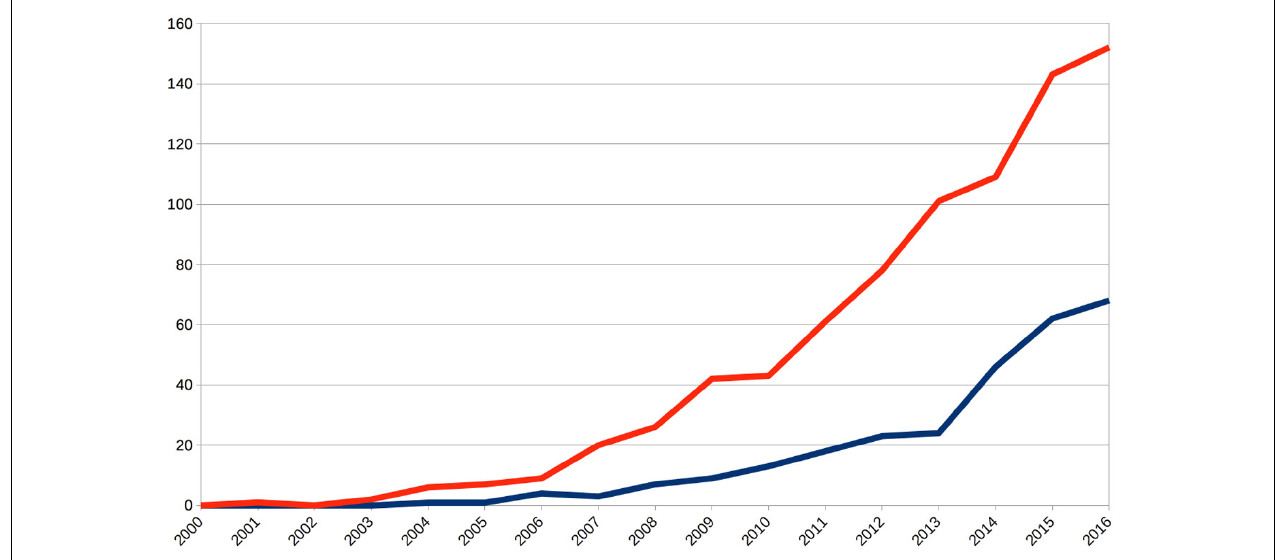
FIGURE 1 | Annual publications show an exponential increase for both topics, biomarkers for mental disorders (blue line) and fMRI research on Major Depressive Disorder (red line). This documents a strongly increasing scientific interest and relevance of the topic of this article. Source: Topic searches on the ISI Web of Science (www.webofknowledge.com) using biomarker ∗ AND “mental disorder ∗ ” and “major depressive disorder” AND fMRI,